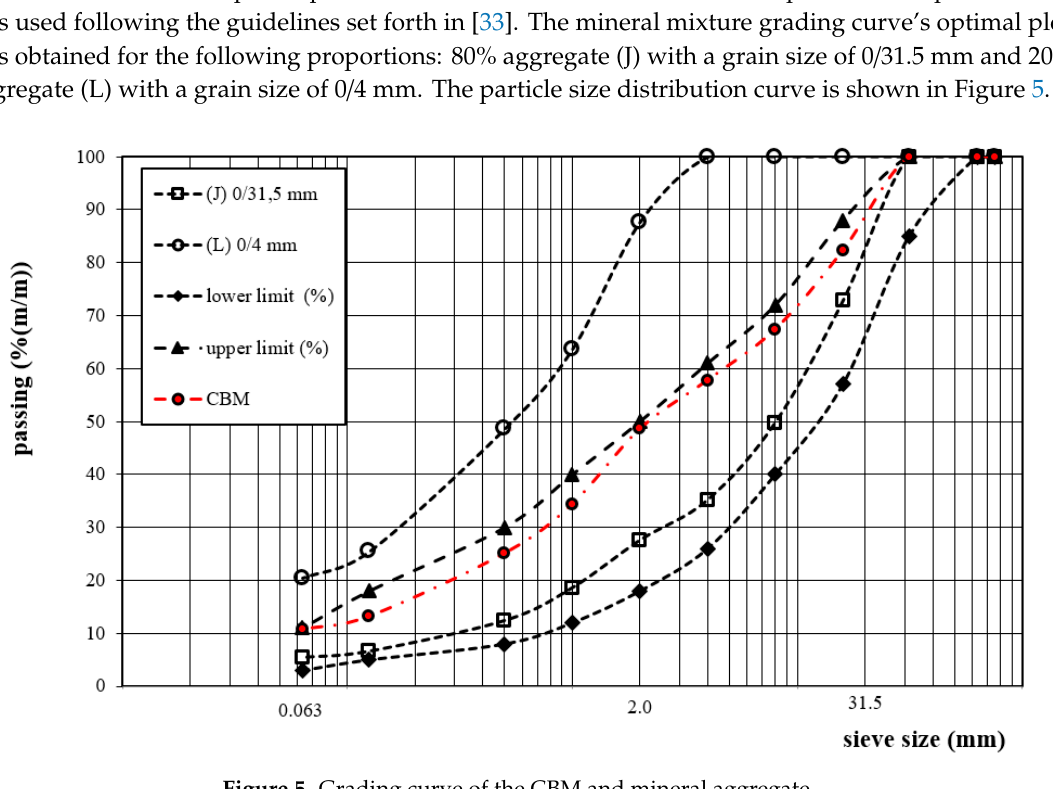
Figure 5. Grading curve of the CBM and mineral aggregate.